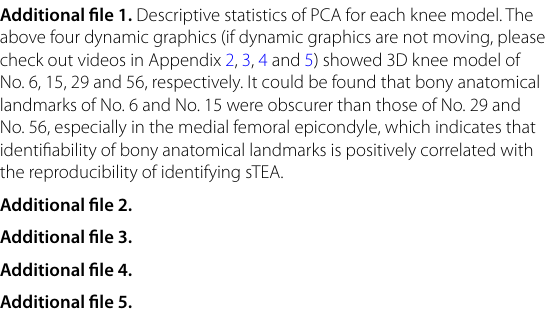
ICC intraclass correlation efficient, CI confidence interval, IQR interquartile